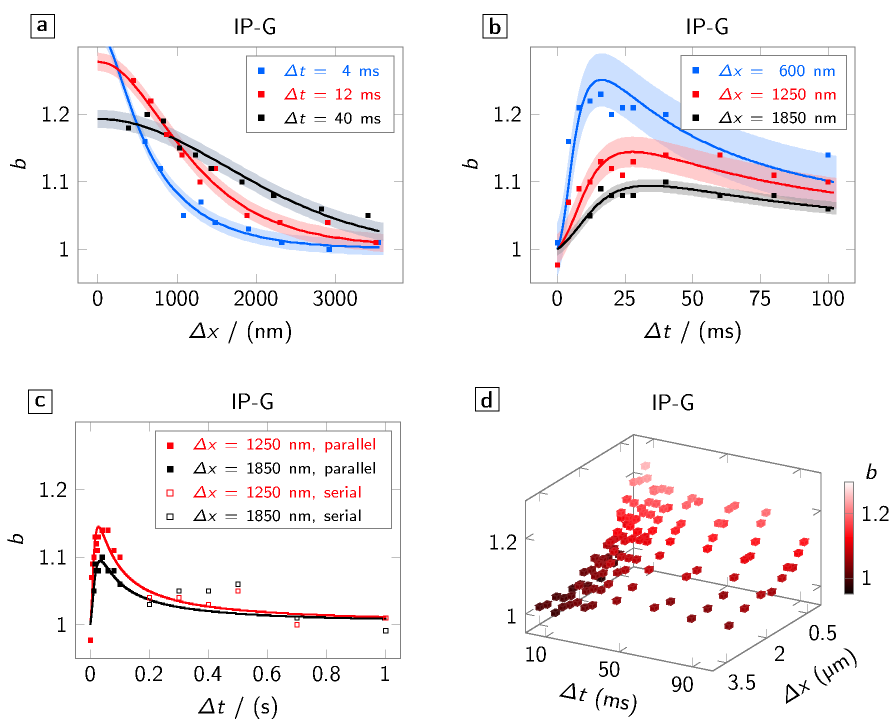
Figure 2. Spatio-temporal characteristics of the broadening b = w t / w l in the gel-like, radical based photo resist IP-G. Squares indicate the measured data, the solid line a model fit to the experimental values, and the underlay the corresponding mean-squared error. ( a ) Spatial characteristics of b for exemplary delays ∆ t ; ( b ) temporal characteristics of b for exemplary separations ∆ x ; ( c ) comparison of temporal characteristics of b in serial (open squares) and parallel (filled squares) writing mode; and ( d ) spatio-temporal characteristics of b